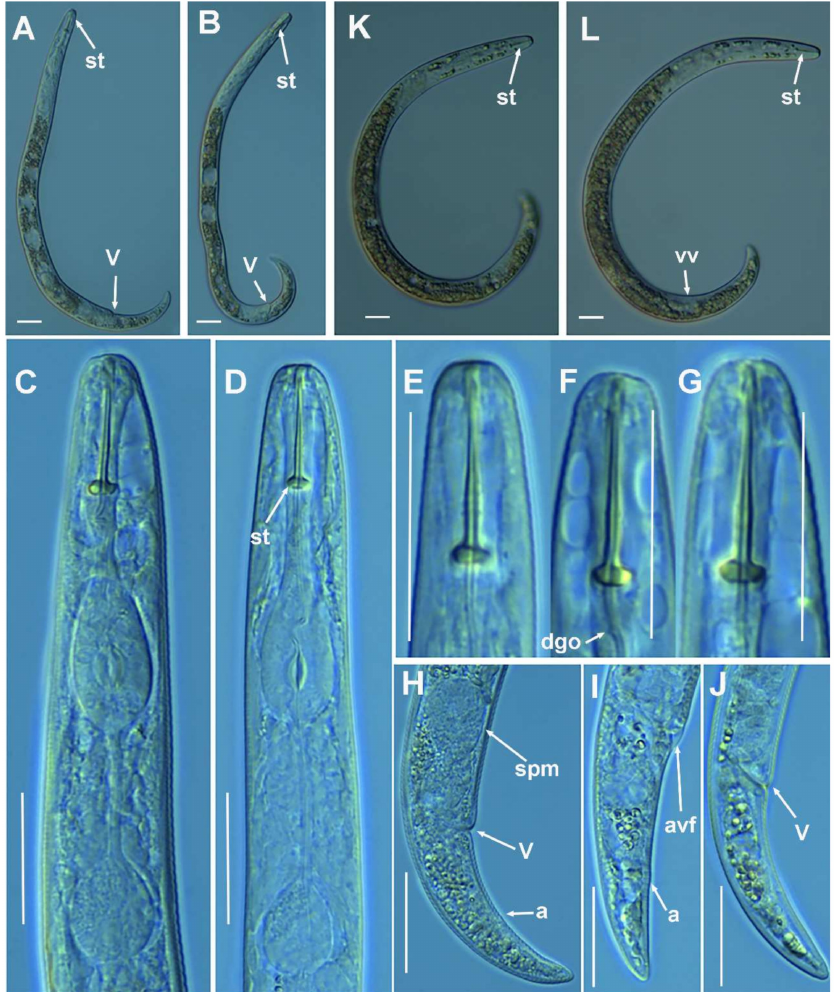
Figure 12. Light photomicrographs of Paratylenchus variabilis Raski, 1975. ( A , B ) Entire female with stylet and vulva arrowed; ( C , D ) female pharyngeal region; ( E – G ) female lip region; ( H – J ) female posterior region with vulva, spermatheca, advulval flap and anus (arrowed); ( K – L ) fourth-stage juvenile with stylet and vaginal vestigium arrowed. Scale bars ( A – L = 20 µ m). (Abbreviations: a = anus; avf = advulval flap; dgo = pharyngeal dorsal gland orifice; spm = spermatheca; st = stylet; vv = vaginal vestigium; V =